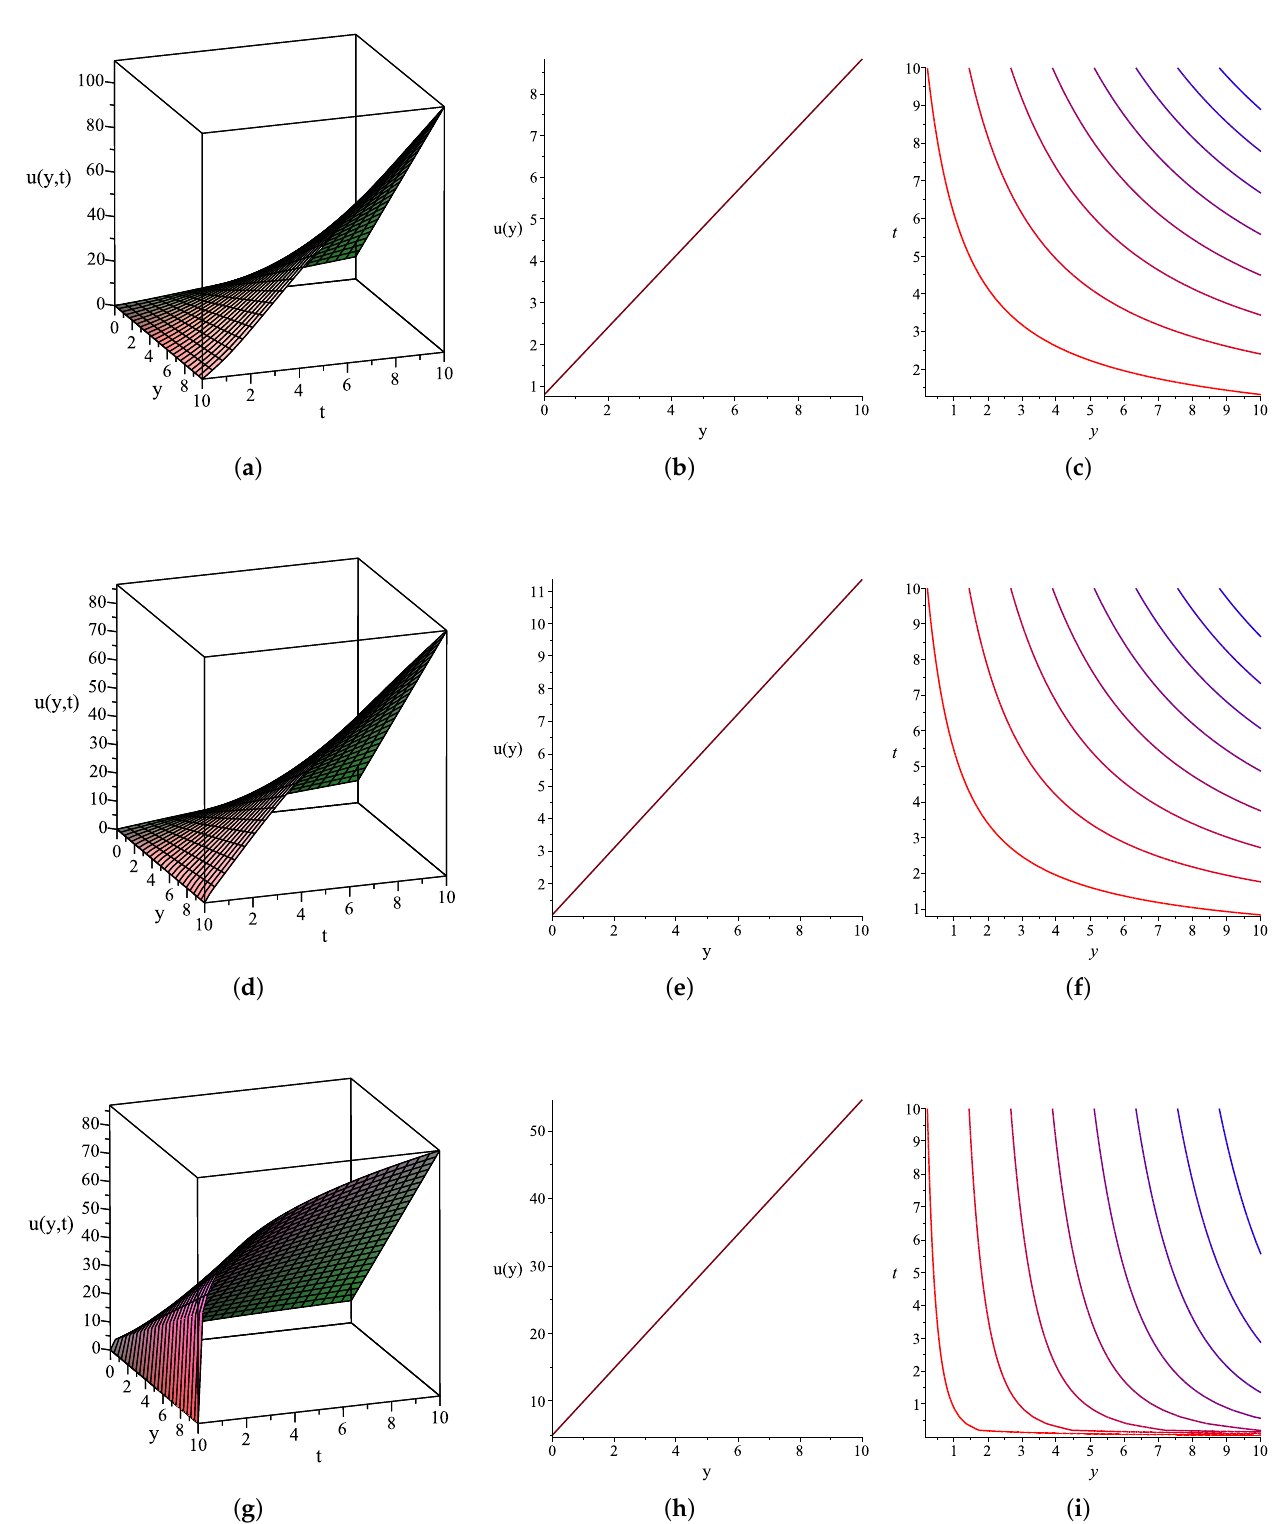
Figure 3. Associated plots of u 7 ( x , y , t ) in Equation (45) obtained using the auxiliary equation method: ( a – c ) 3-D plot, 2-D plot and contour plot, respectively when α = 1; ( d – f ) 3-D plot, 2-D plot and contour plot, respectively when α = 0.8; ( g – i ) 3-D plot, 2-D plot and contour plot, respectively when α =